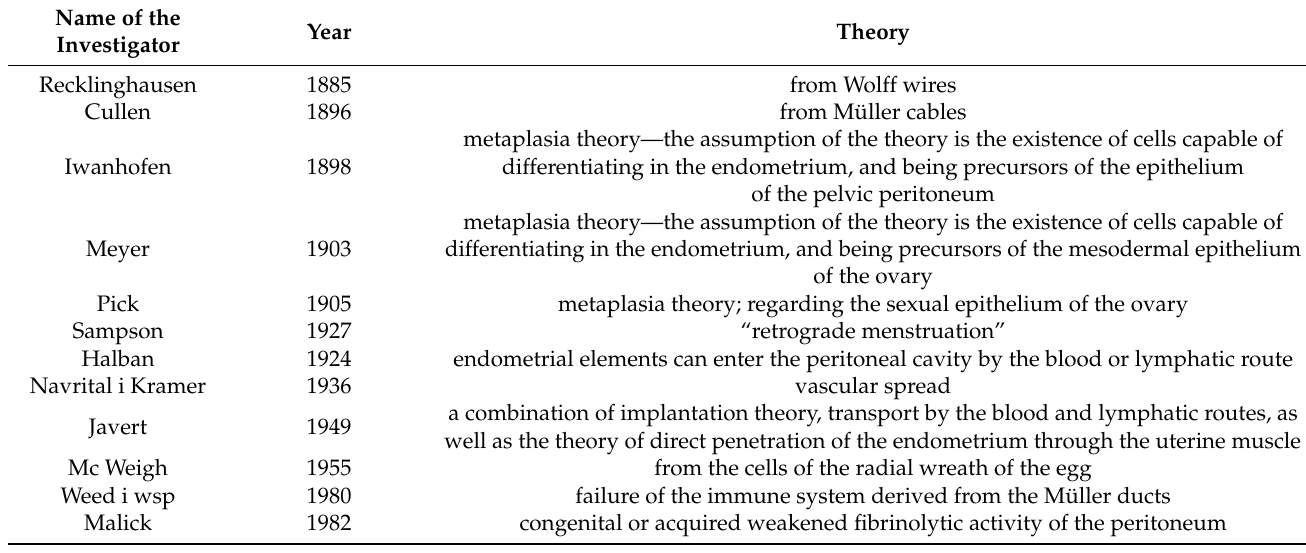
Table 1. Theories of the formation of endometriosis—a historical